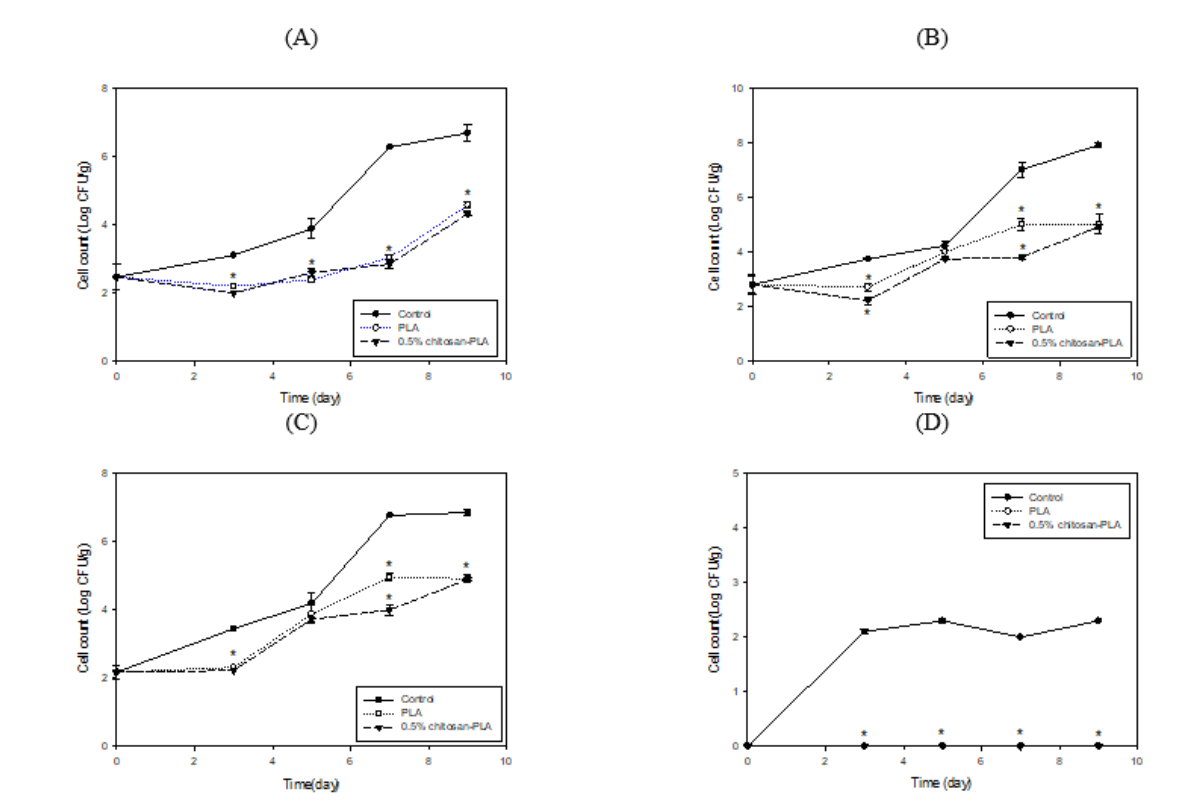
Figure 6. Changes in cell counts of coliforms ( A ); Aeromonas ( B ); Pseudomonas ( C ); and Vibrio ( D ) groups of fish fillet ( Epinephelus fuscoguttatus x Epinephelus lanceolatus ) uncovered (control) or covered with PLA or 0.5% CH–PLA film during storage at 4 ◦ C. Data are presented as mean ± SD ( n = 3). * significantly different compared to control ( p <